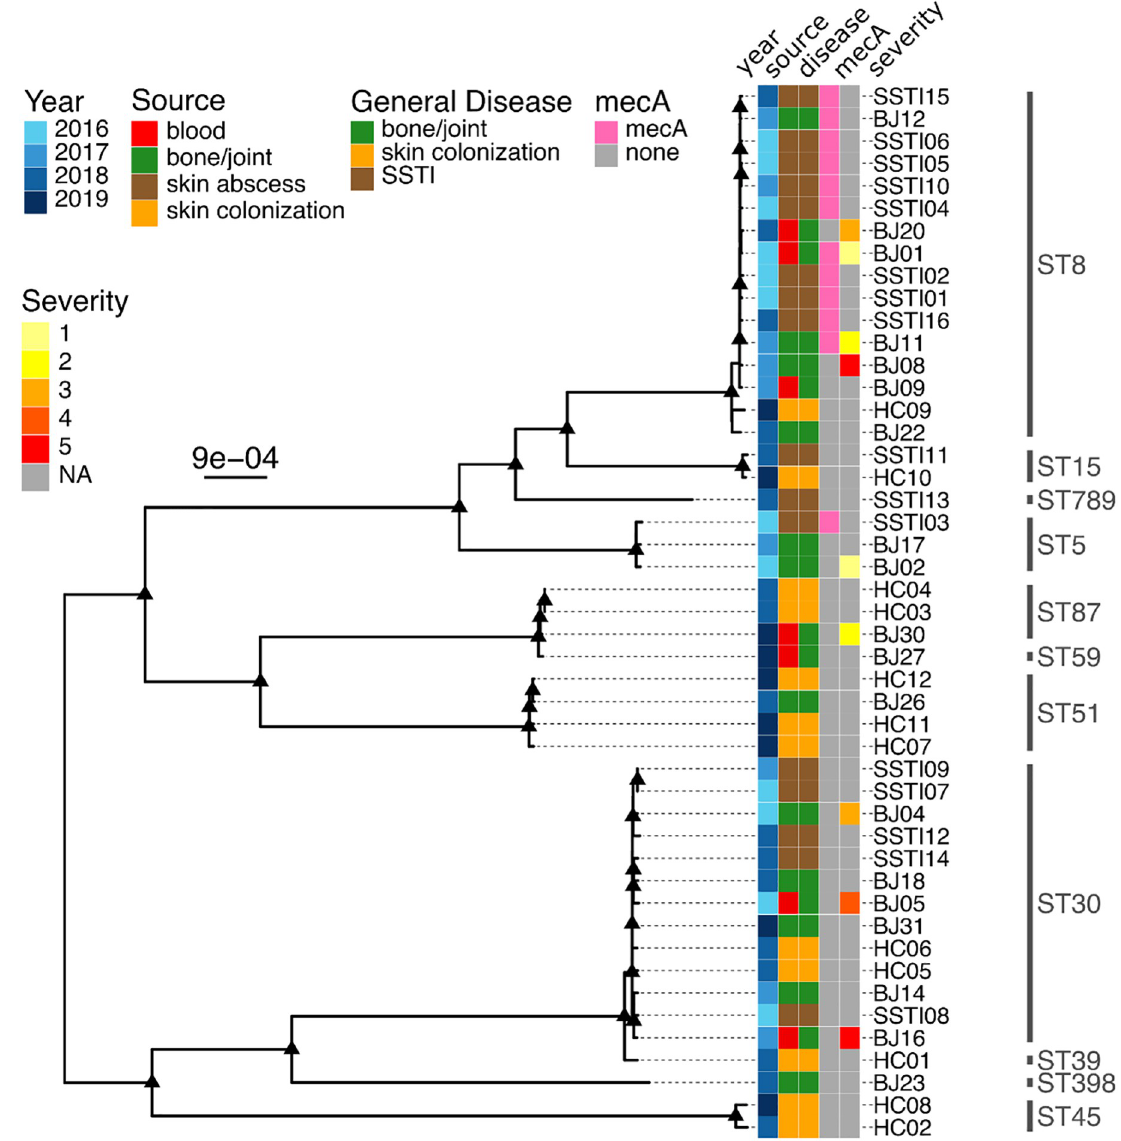
Fig 1. Phylogenetic analysis of Staphylococcus aureus isolates from children with osteoarticular infections compared with children with skin and soft tissue abscesses and healthy controls. Maximum likelihood phylogeny of 47 S . aureus genomes. Each isolate originates from a different patient. This phylogeny was generated from a core genome alignment, and it is midpoint rooted. Branches are color-coded by the year, source of the sequenced isolate, the patient’s general disease, and the presence/absence of mecA and a disease severity score for patients with acute osteomyelitis (scale from 1, lowest to 10, highest). Sequence types are shown at the right. The scale bar indicates nucleotide substitutions per site. Triangles indicate nodes with ultrafast bootstrap support of at least 95%. BJ = bone and/or joint infection; SSTI = skin/soft tissue infection; HC = healthy